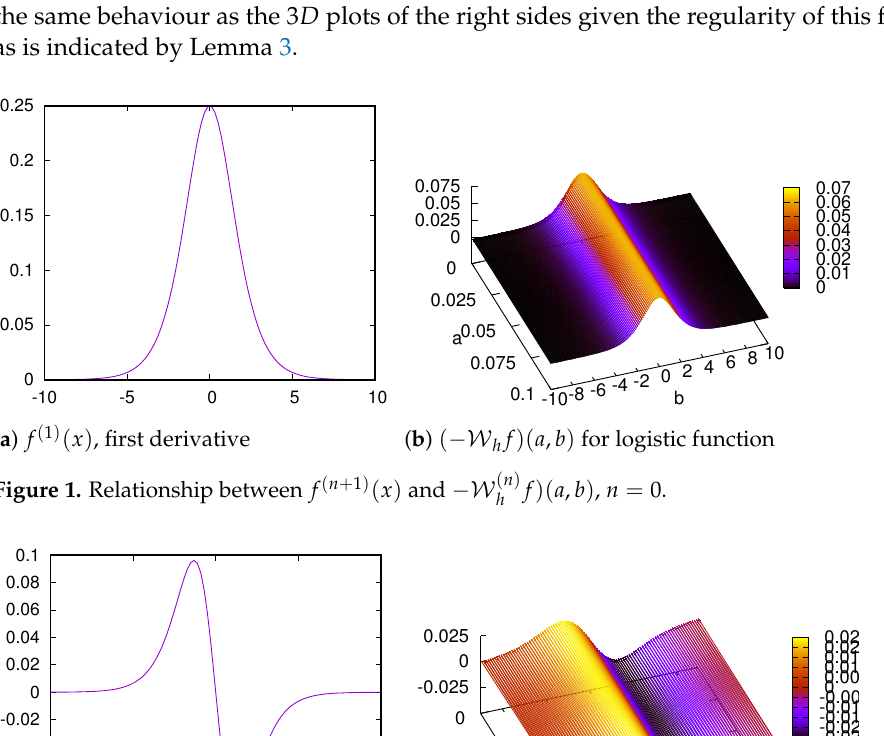
Figure 2. Relationship between f ( n + 1 ) ( x ) and −W